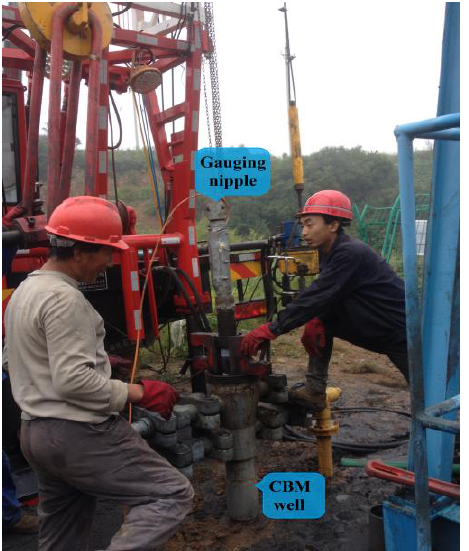
Figure 10. Field of the gauging nipple entering the well.